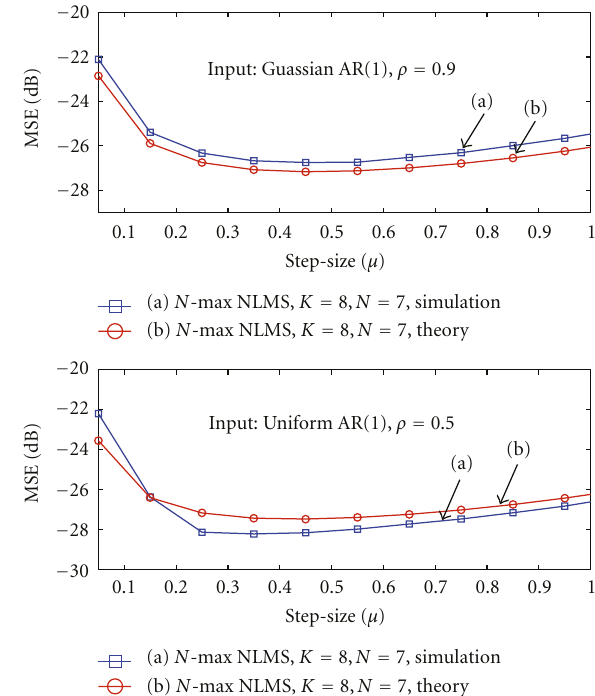
Figure 3: Steady-state MSE of N -Max NLMS with M = 8 and N = 5 as a function of the step size in nonstationary environment for di ff erent input signals.